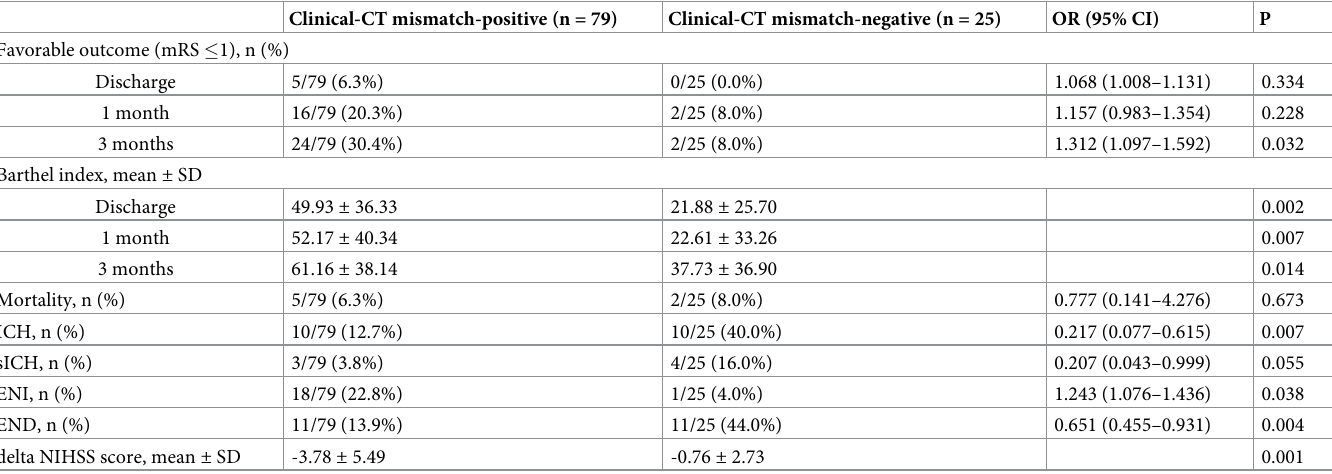
Table 2. Clinical outcomes of patients with cerebral infarction receiving intravenous thrombolysis as classified by clinical-CT